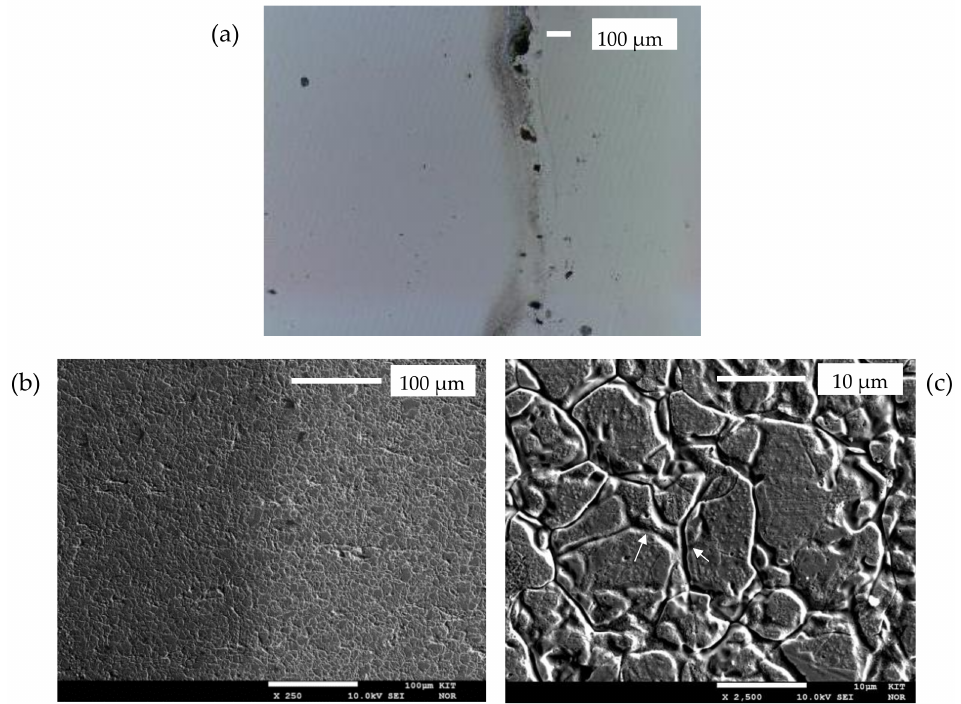
Figure 6. Top view of the coatings on different substrates (left-hand side: coated; right-hand side: uncoated. ( a ) FAS on silicon substrate—optical profilometry 10 × ; ( b ) FAS on SS-flat substrate—SEM; ( c ) detail of the coated part on the SS-flat substrate: Effect of pickling pre-processing can be seen in the grain boundaries (white